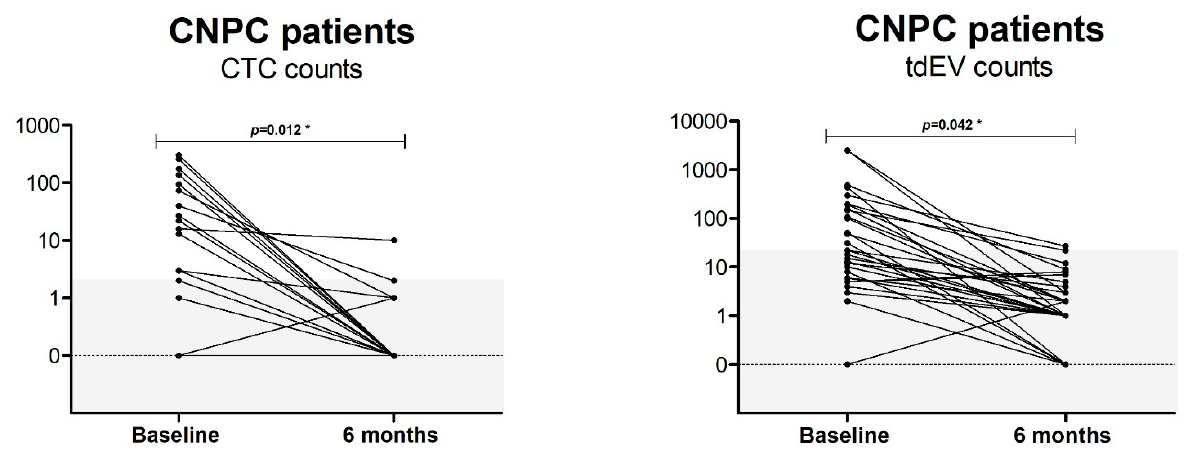
Figure 8. Baseline CTC/tdEV counts and CTC/tdEV counts after 6 months of ADT of 31 CNPC patients. The gray area indicates the background CTC and tdEV count detected in healthy individuals. The decrease in CTC and tdEV counts pre ‐ and post ‐ therapy were statistically significant with p = 0.012 for CTCs and p = 0.042 for tdEVs. * Significance p < 0.05.